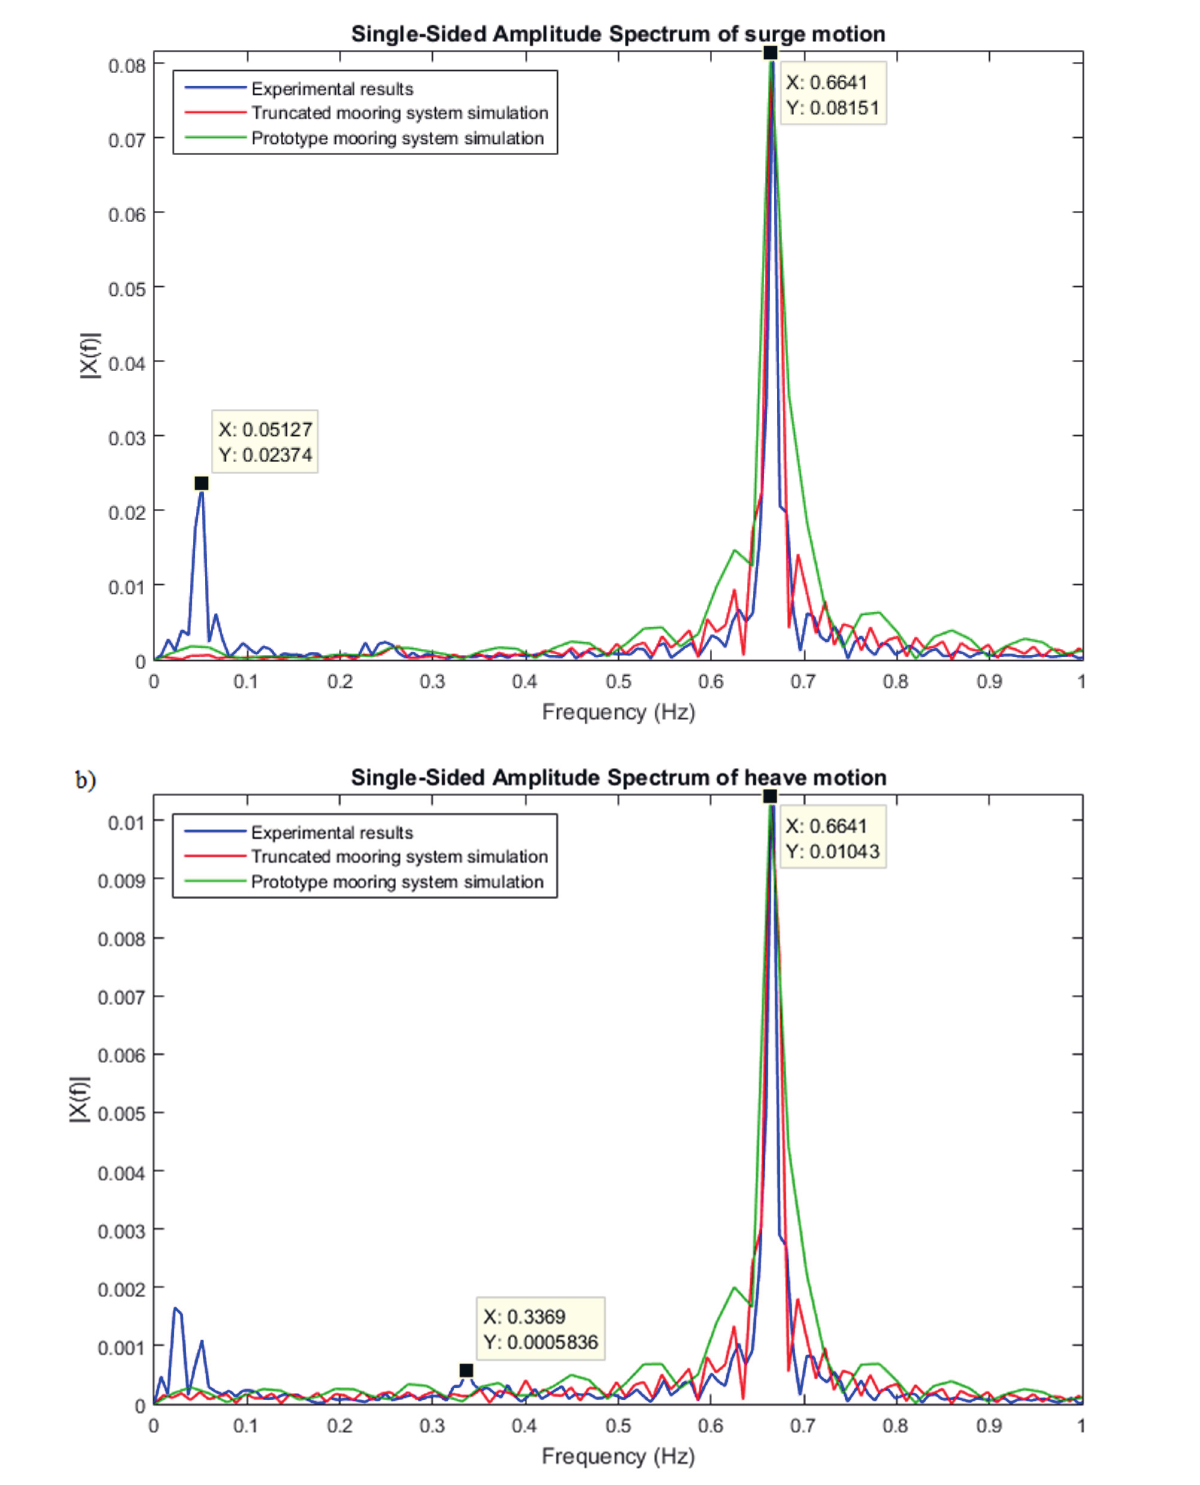
Figure 15. Surge ( a ) and heave ( b ) motion Fast Fourier Transform